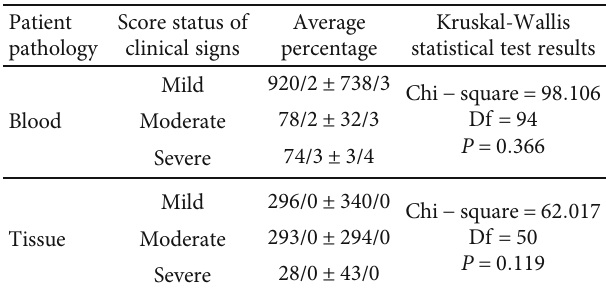
Table 3: Comparison of the mean percentage of blood and tissue eosinophils in patients according to the condition of clinical